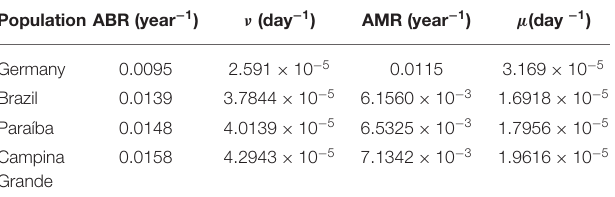
TABLE 2 | Birth and death rates.